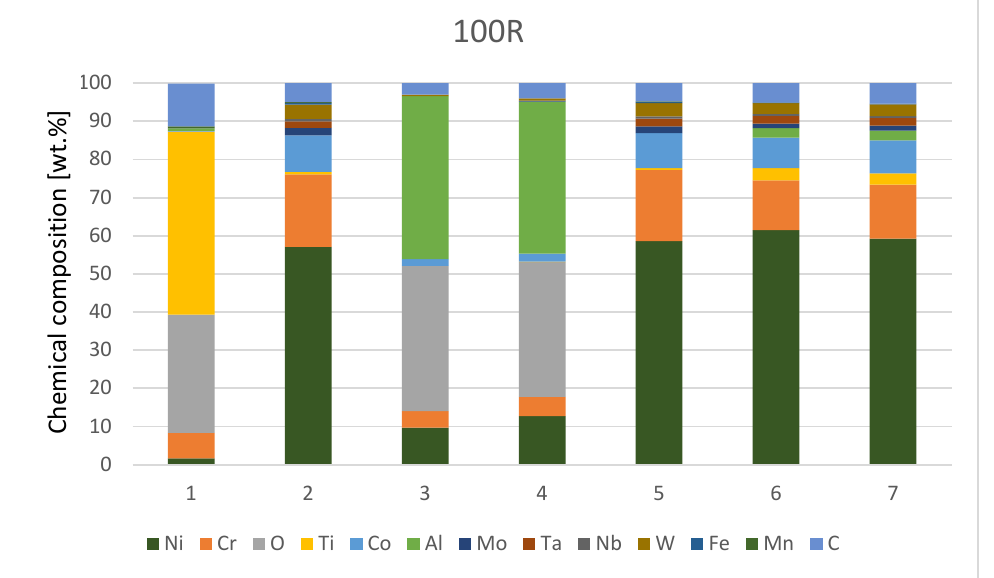
Diagram 2. Chemical composition [wt.%] of IN738—50R after He exposure. Diagram 2. Chemical composition [wt.%] of IN738—100R after He